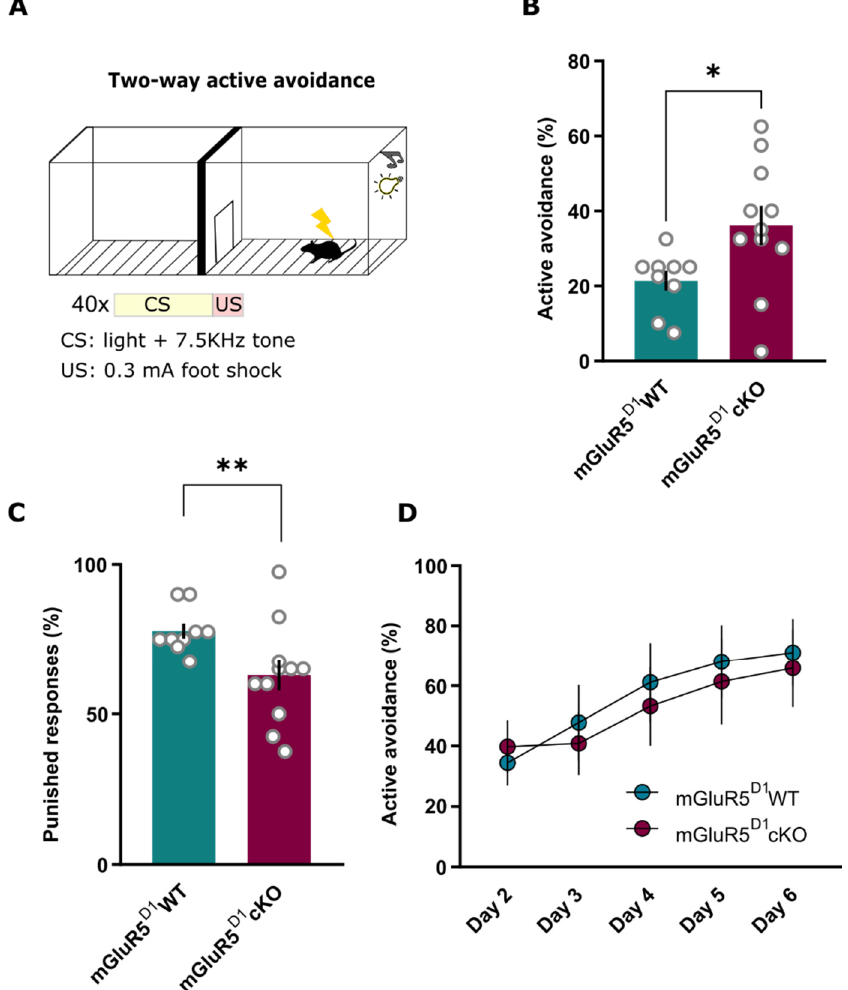
Figure 6. ( A ) Scheme of the two-way active avoidance (TWA) test. ( B ) mGluR5 D1 cKO mice avoided more foot shocks during the first exposure (Day 1) to the TWA test than their WT littermates. Mann–Whitney, U = 18, p = 0.014. ( C ) mGluR5 D1 cKO mice received less punished responses during the first exposure (Day 1) to the TWA test than their WT littermates. Mann–Whitney, U = 16.5, p = 0.010. ( D ) Both mGluR5 D1 WT and cKO mice increased the number of avoided foot shocks with repeated testing in the TWA (Day 2–6) to a similar extent. Two-way ANOVA, main effect genotype: F(1, 25) = 0.081, ns ( p = 0.77); main effect day: F(1, 25) = 8.97, p = 0.0001; interaction effect: F(1, 25) = 0.37, ns ( p = 0.82); n = 9 mGluR5 D1 WT, n = 11 mGluR5 D1 cKO mice. * p ≤ 0.05; ** p ≤ 0.01.